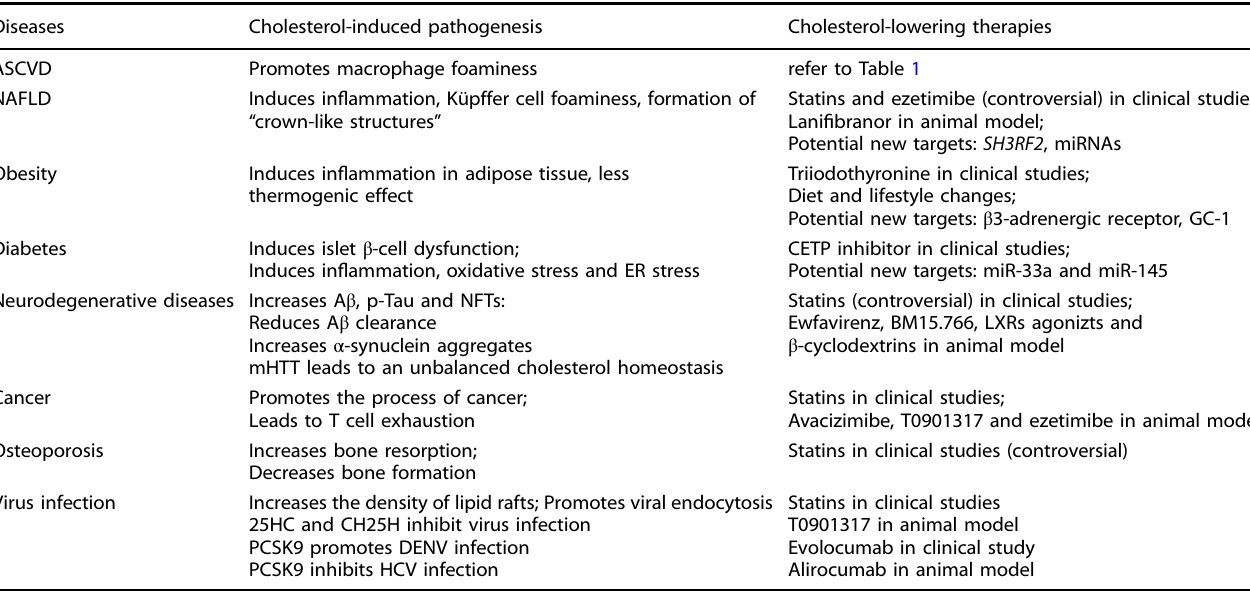
Diseases Cholesterol-induced